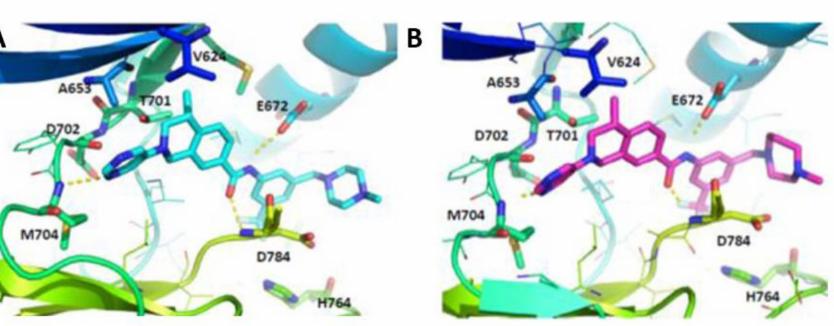
Figure 8. Docking models of compounds 21 ( A ) and 23 ( B ) into DDR1 binding pocket. Reprinted from Ref.